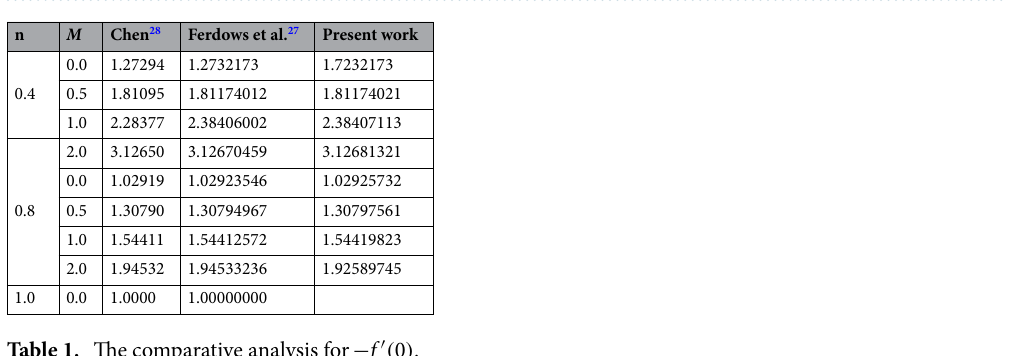
Table 1. The comparative analysis for − f ′ ( 0 )